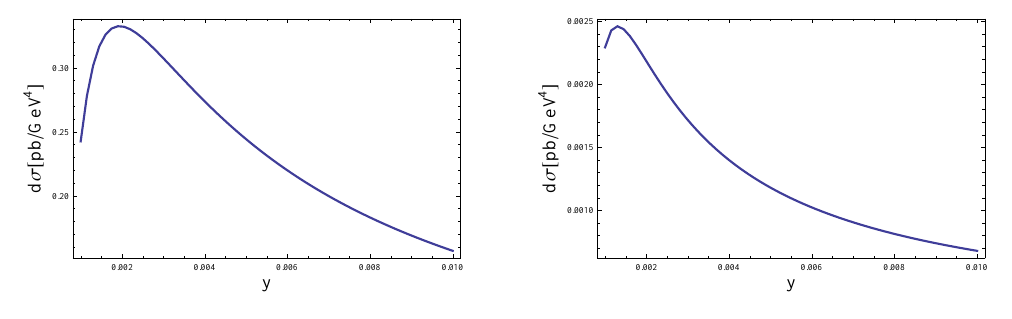
Figure 3: Left panel : The Q 2 dependence of the cross section = 0 and s = 20000 GeV 2 and y = 10 − 3 (solid curve) , y = 5 · 10 − 3 GeV − 4 ) for ∆ T (dashed curve) and y = 10 − 2 (dotted curve). Right panel : The y dependence of the ) d σ ( e − N → ν ND − s (in pb GeV − 4 ) for Q 2 = 0.1 GeV 2 , ∆ cross section d y dQ 2 dt GeV 2 .